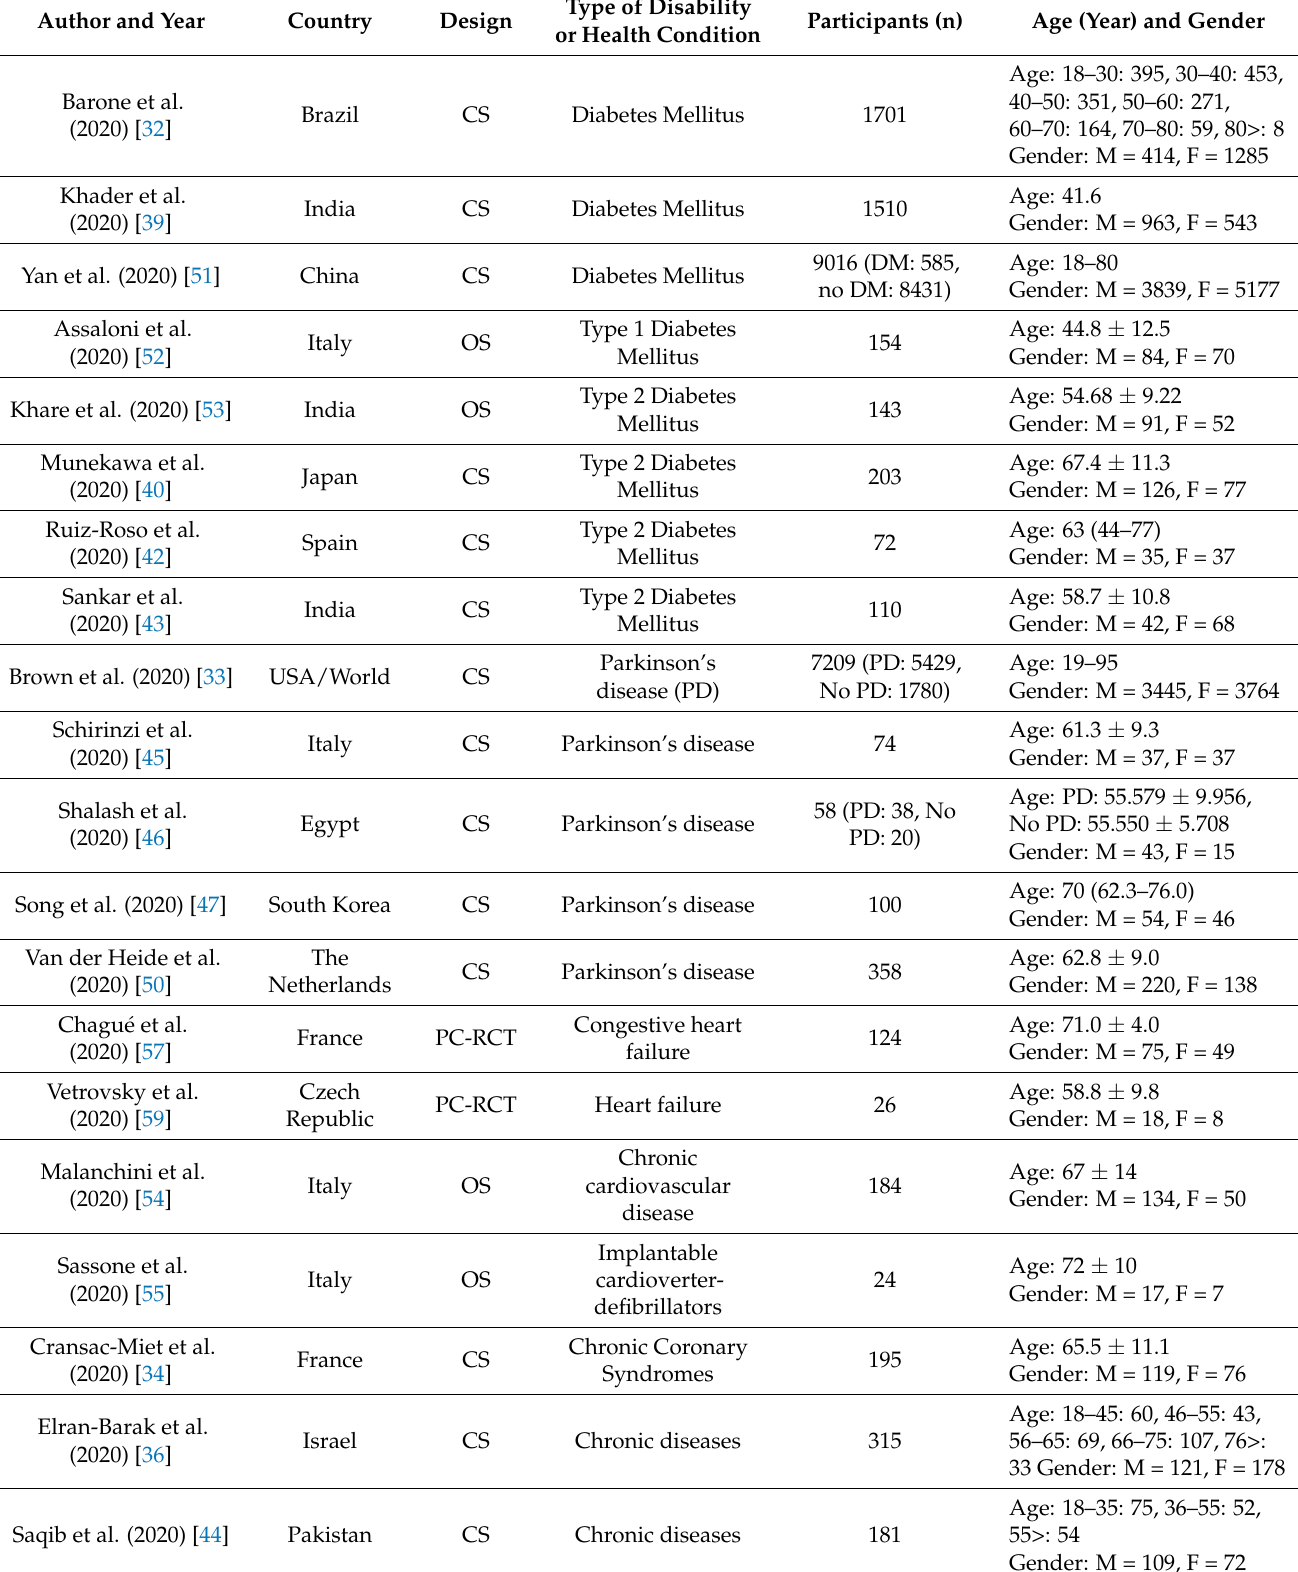
Table 2. The study characteristics of the included